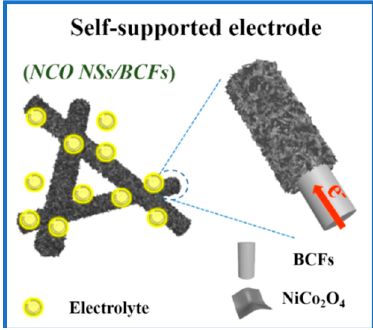
Figure 7. Schematic diagram of the self-supported NCO NSs/BCFs electrode.